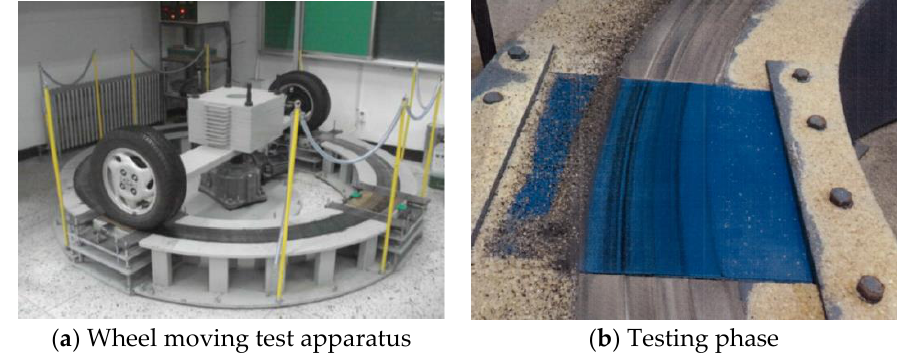
Figure 5. Abrasive wear resistance to wheel-moving test.